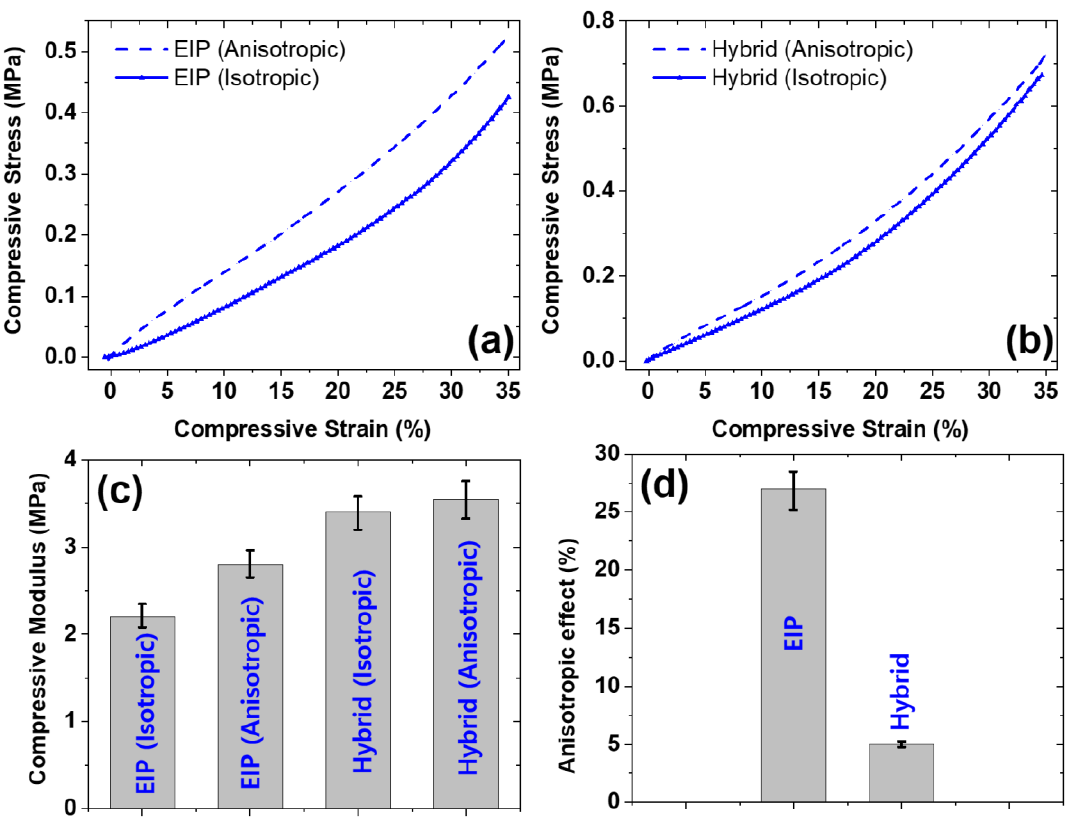
Figure 7. Iso-anisotropic compressive stress–strain behavior at 60 phr and 1 T magnetic field of ( a ) EIP filled composites; ( b ) hybrid-filled composites; ( c ) compressive modulus for different composites; ( d ) anisotropic effect of different composites.